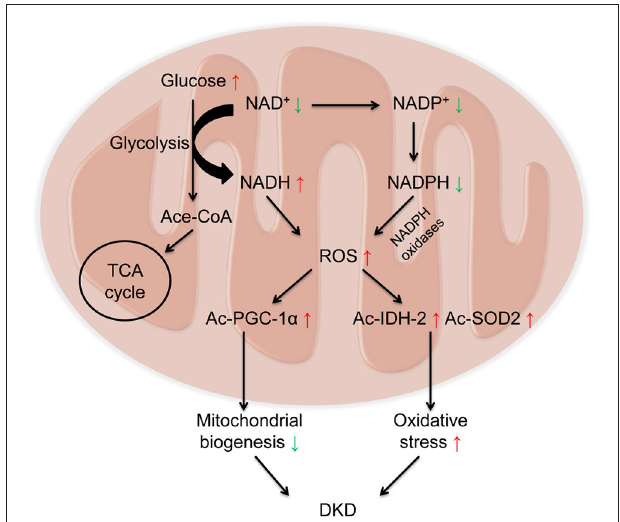
FIGURE 2 | Decreased NAD + and increased Reactive oxygen species (ROS) in diabetic kidney disease (DKD). Under diabetic condition, glucose is metabolized to acetylated-CoA, which enters the tricarboxylic acid cycle (TCA) cycle via consuming NAD + . On one hand, NAD + receives hydrogen to be reduced into NADH, leading to the overload of NADH and the elevated levels of ROS. On the other hand, NADPH oxidases transfer electrons from NADPH and interact with oxygen to form superoxide to aggravate the production of ROS. Overloaded ROS in mitochondria results in the acetylation of peroxisome proliferator-activated receptor gamma coactivator 1 α (PGC-1 α ) to impair mitochondrial biogenesis, and acetylation of isocitrate dehydrogenase 2 (IDH2) and superoxide dismutase 2 (SOD2) to aggravate oxidative stress, ultimately leading to the progression of